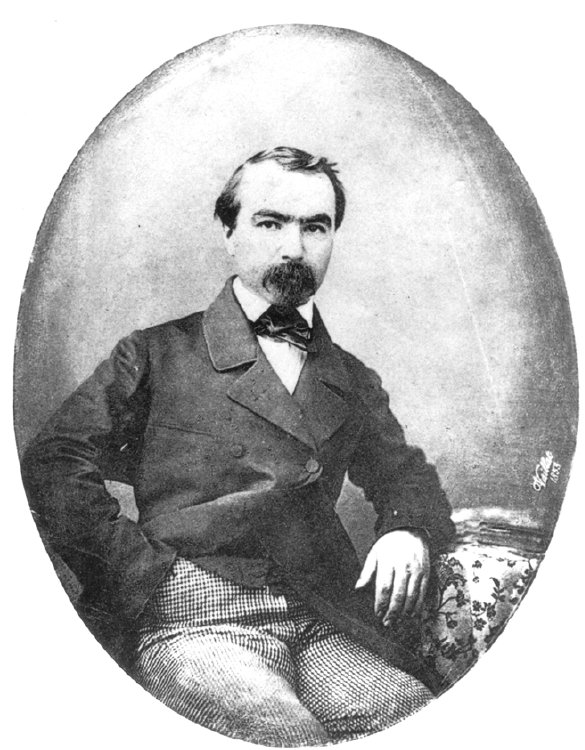
Figure 1. Captain Laussedat in